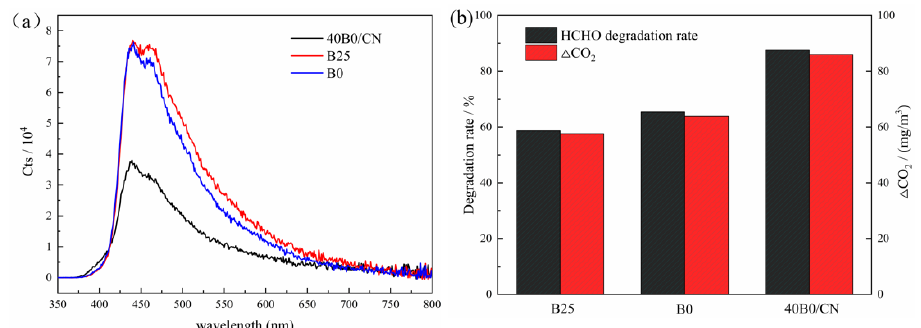
Figure 8. Photoluminescence spectra ( a ) and formaldehyde degradation rate under sunlight ( b ) of B25, B0 and 40B0/CN composites.